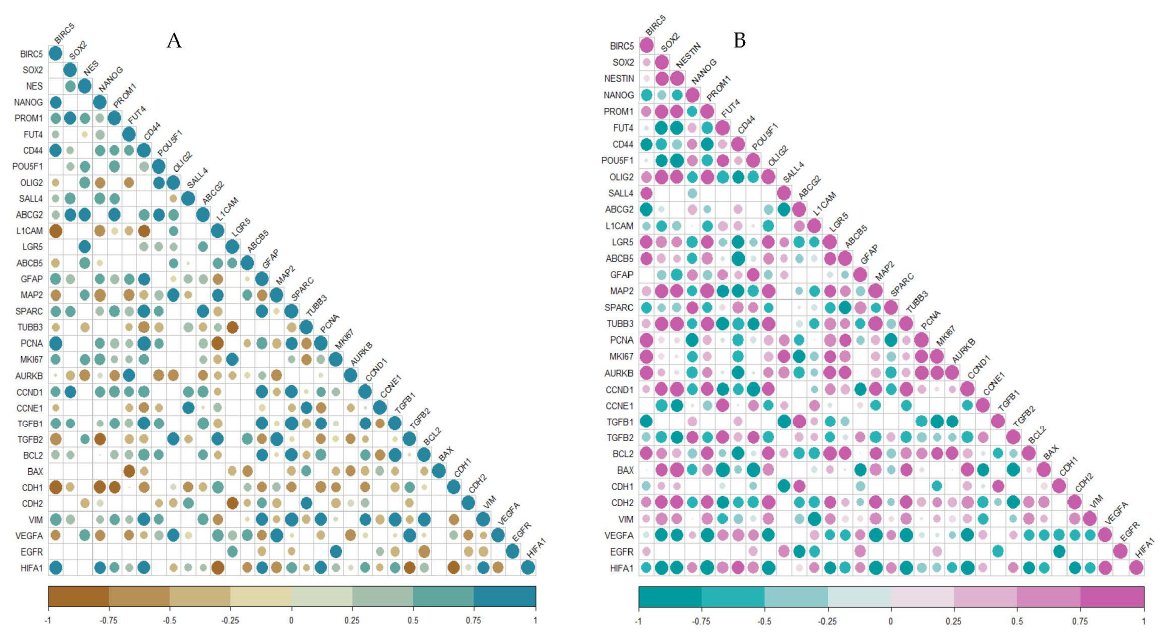
Figure 4. Correlogram of genes from GSE15209. ( A ) Normal; ( B ) GSC. The size of the circle indicates the significance of the p -values; non-significant ones are blank with no circles.